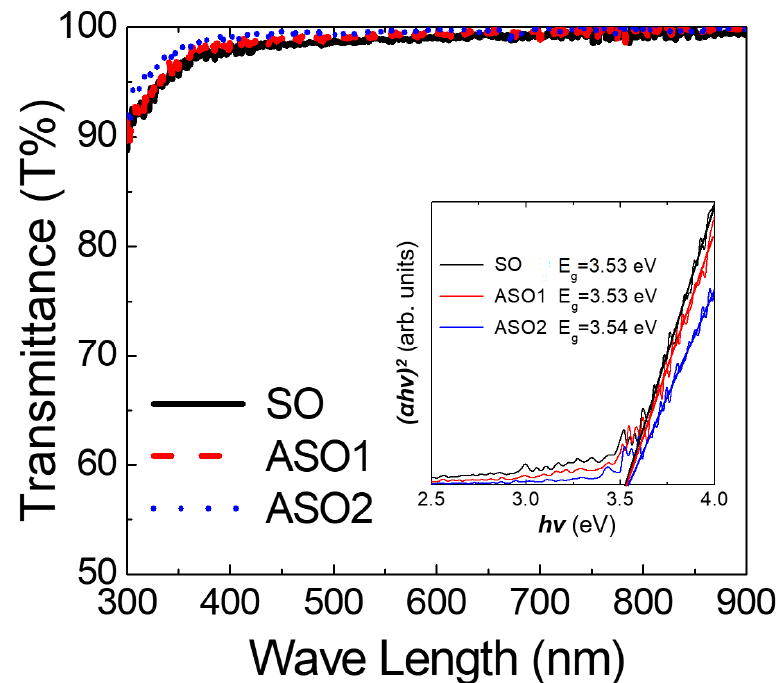
Figure 5. Optical transmittance values as a function of wavelength and (inset) Tauc plot as a function of photon energy ( h ν ) for the SO, ASO1, ASO2 thin films with different Al concentrations.